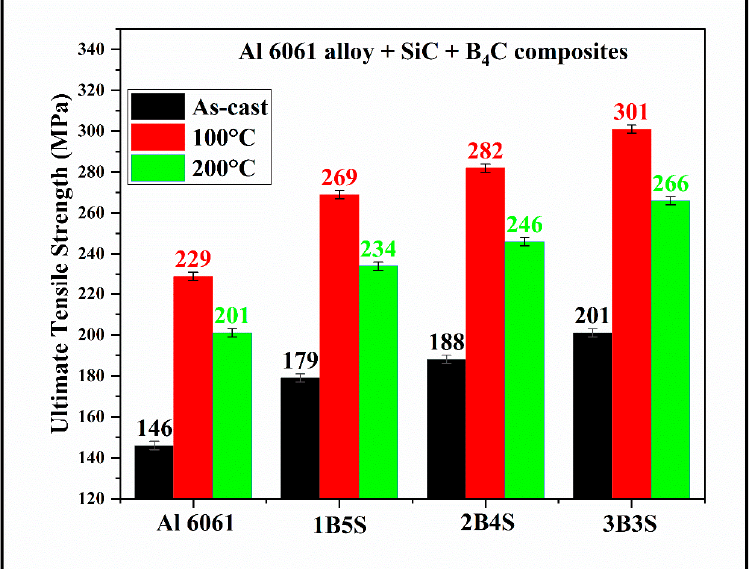
Figure 7. Variation of tensile strength with different quantity of SiC and B 4 C particles on Al 6061 hybrid composites under different aging conditions. hybrid composites under different aging